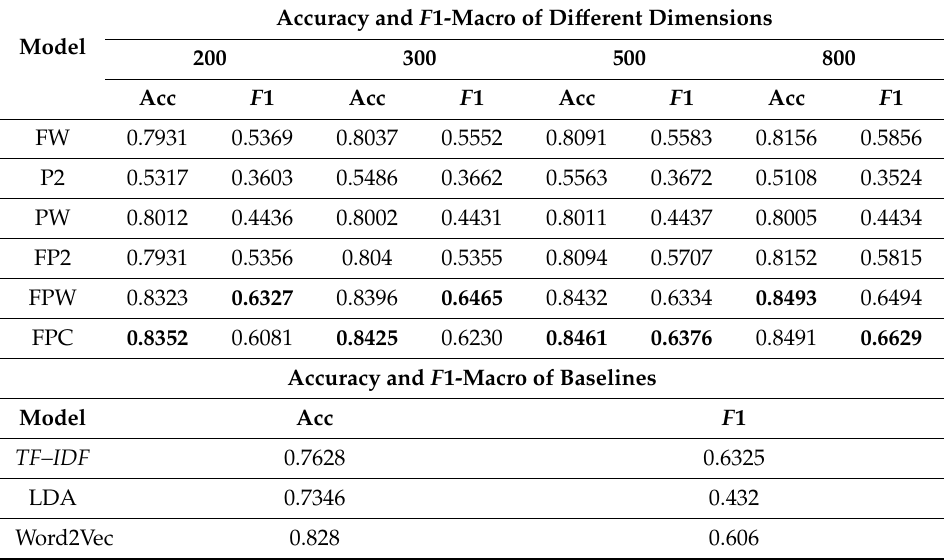
Table 8. Results of FudanNLP in 17 classes for 4117 texts by